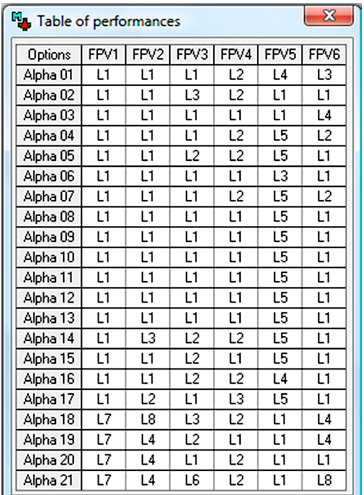
Table 2. Levels of partial performance revealed by the customers